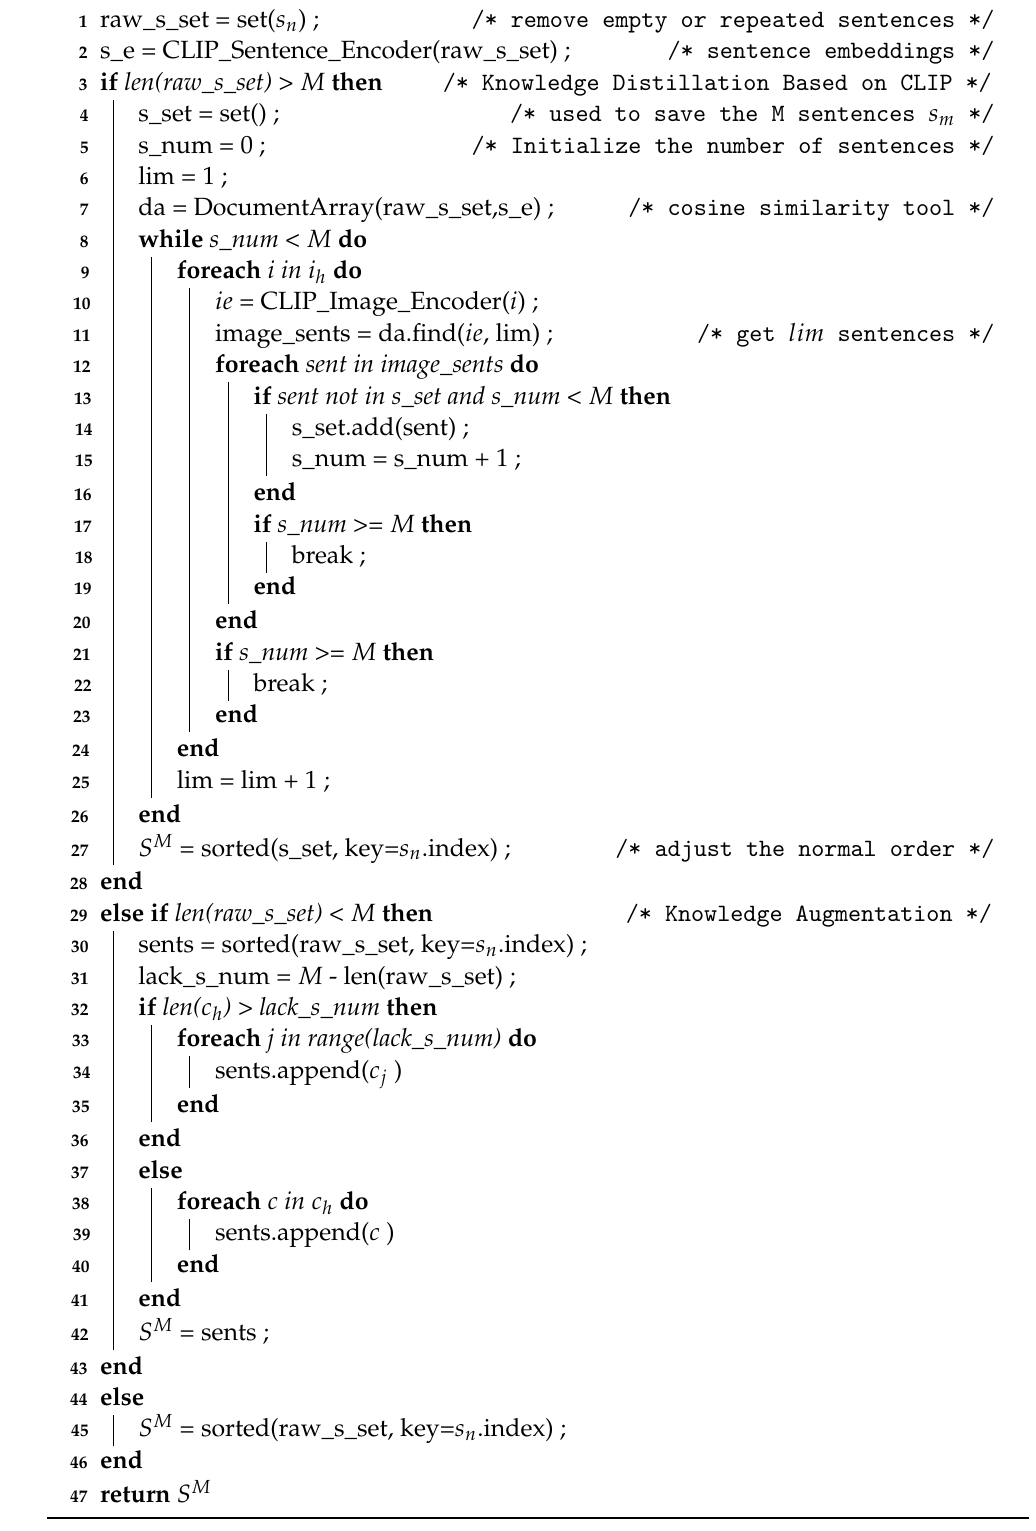
Algorithm 1: Knowledge distillation/augmentation